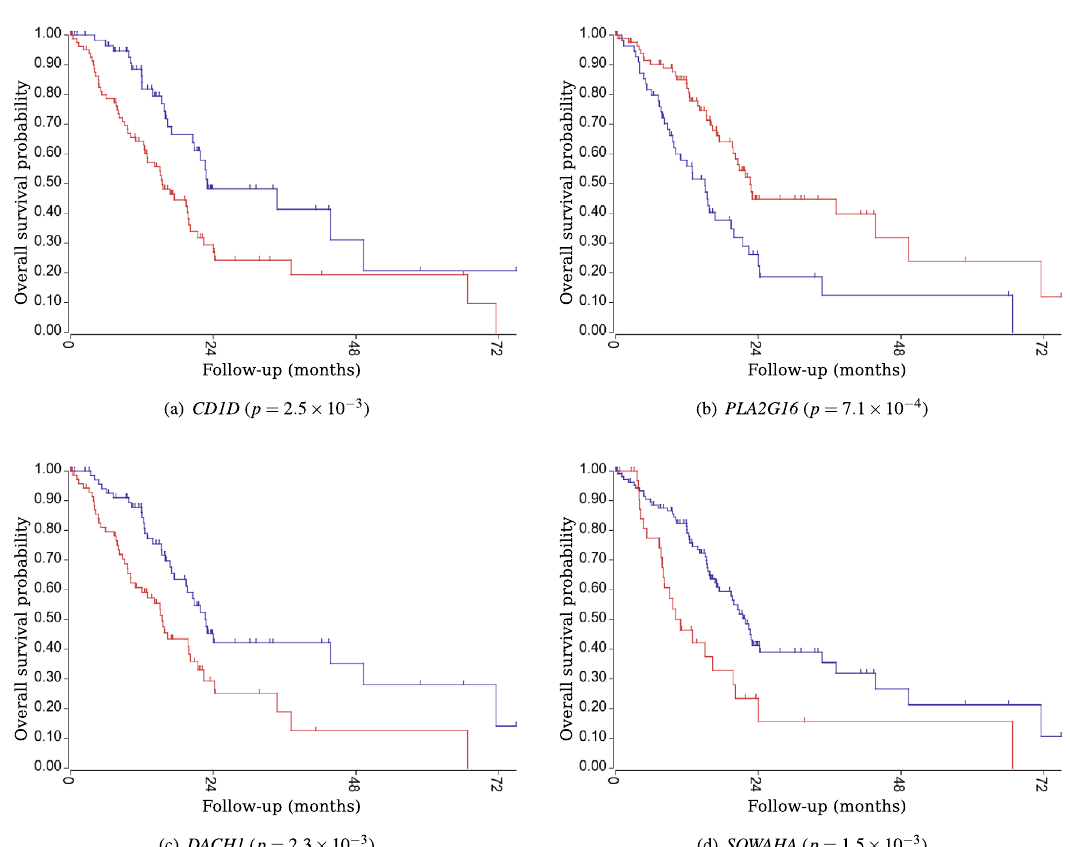
Figure 5. Kaplan meier plots for the top three genes in Task 2. The top three genes were CD1D , PLA2G16 , and SOWAHA at N = 10 , and PLA2G16 , DACH1 , and CD1D at N = 50 . These genes were significant prognosis